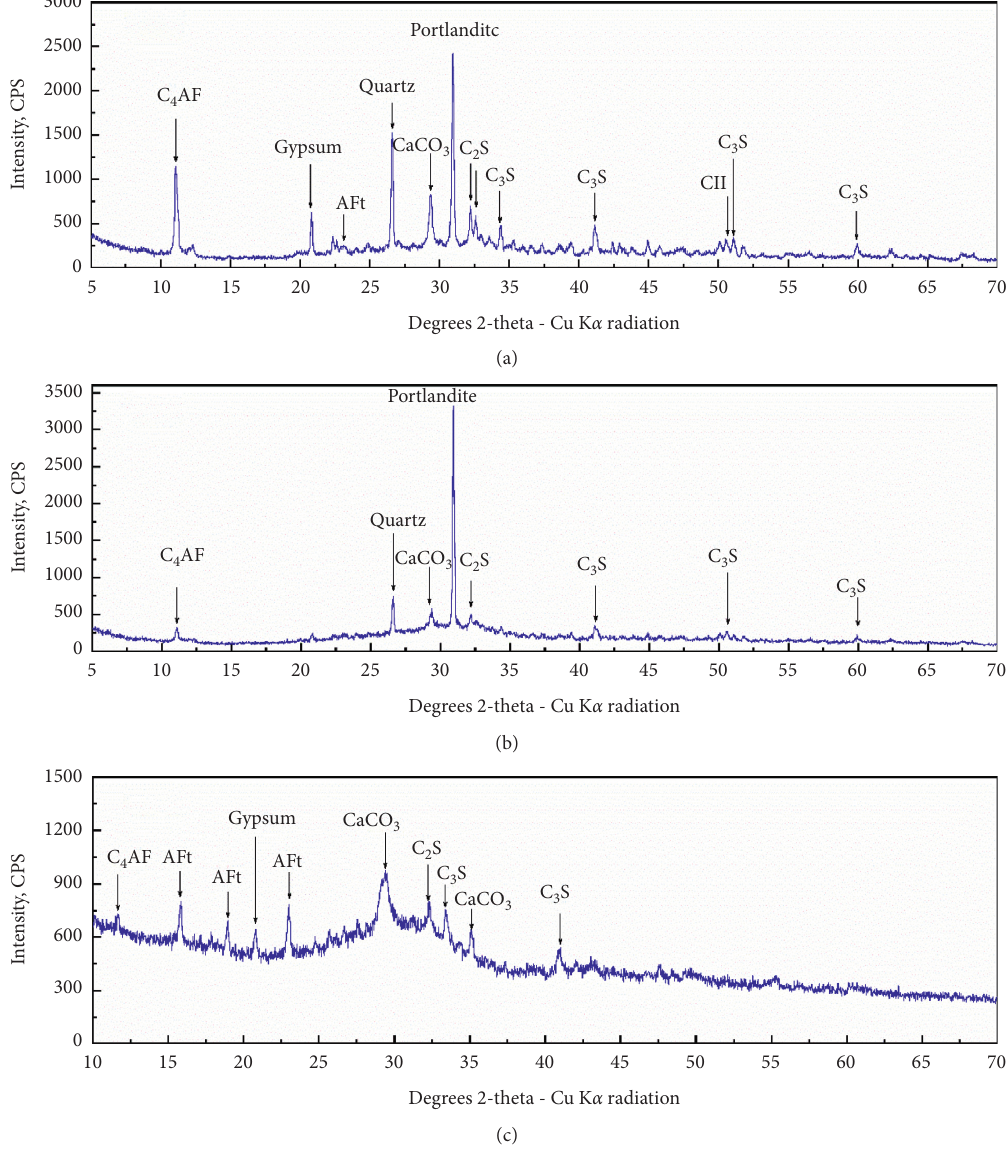
Figure 5: XRD patterns for (a) CB, (b) BB, and (c) SB pastes after curing for 28